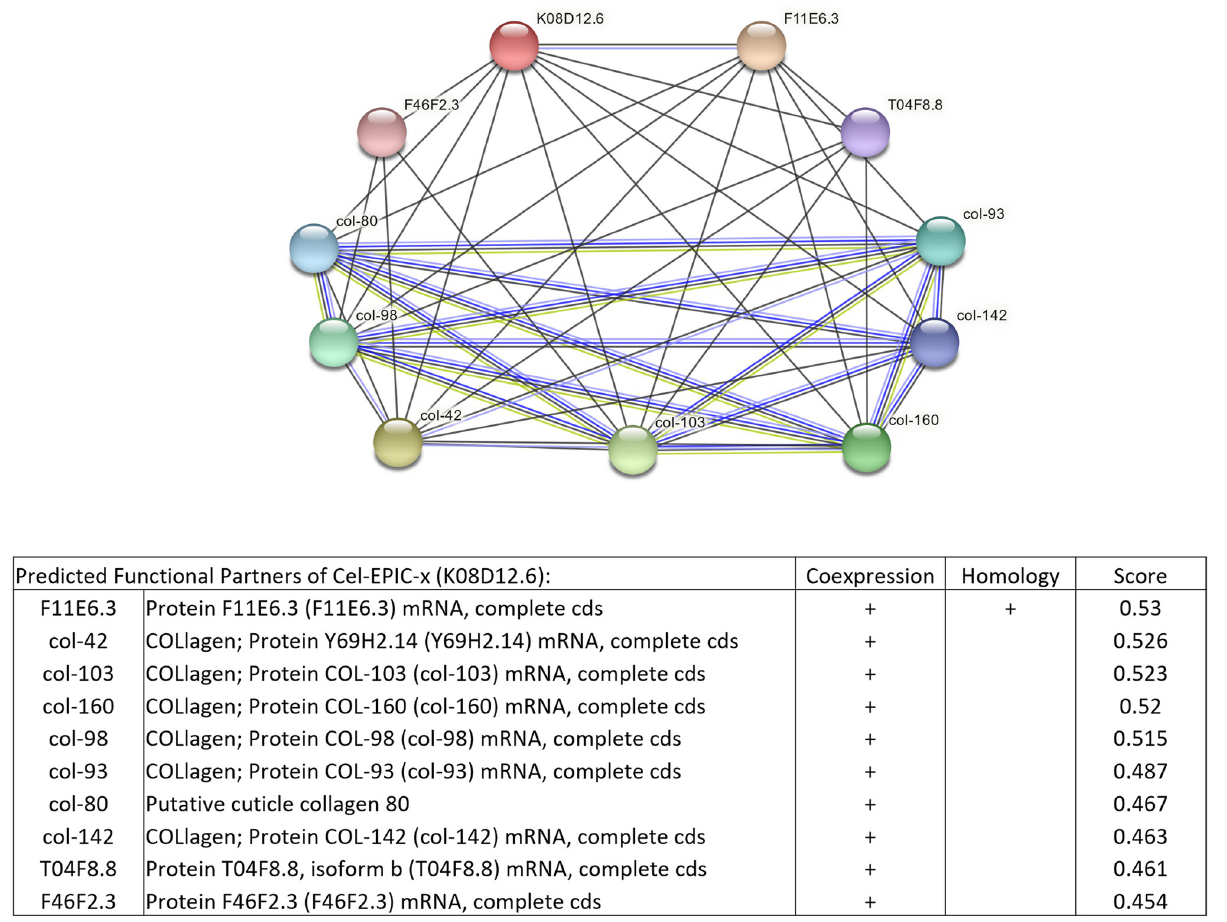
Fig 7. Scheme of STRING analysis of the C . elegans epicuticlin Q8MXU8 (K08D12.6) to show potential interactions of this epicuticlin with the second epicuticlin Q9U3J8 (F11E6.3), cuticular collagens, and other proteins rich in tyrosine. The red-colored node represents the query protein, and the other nodes are the first shell of interactors. Co-expression and homology analysis are indicated in the Table. Each protein-protein interaction is annotated with ’scores’, which are confidence indicators. All scores rank from 0 to 1, with 1 being the highest possible confidence. A score of 0.5 indicates that roughly every second interaction might be erroneous (i.e., a false positive) [39].